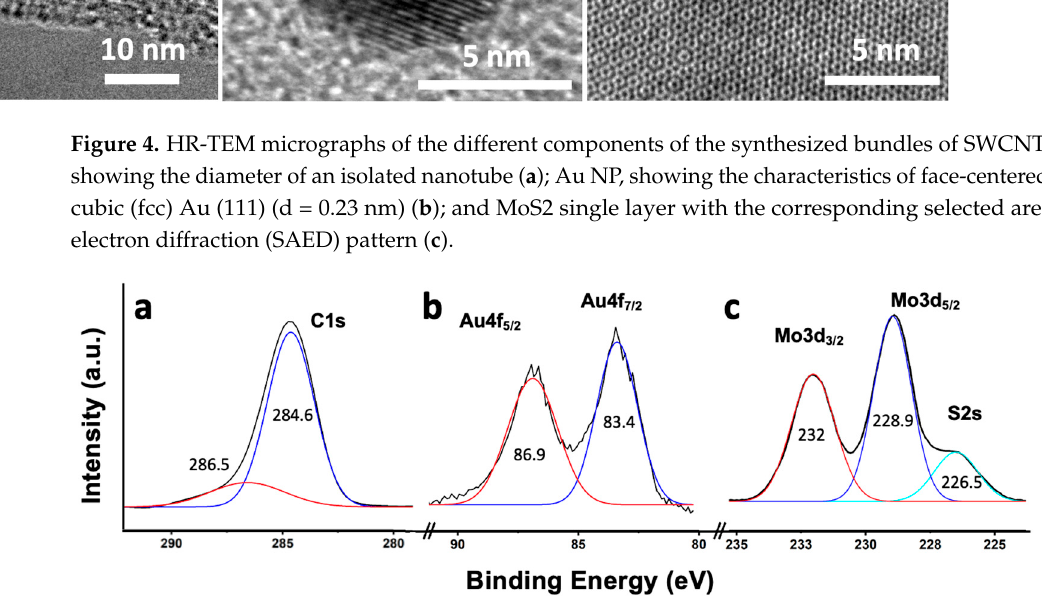
Figure 5. XPS core level spectra for C1s (a); Au4f (b); and Mo3d/S2s (c).